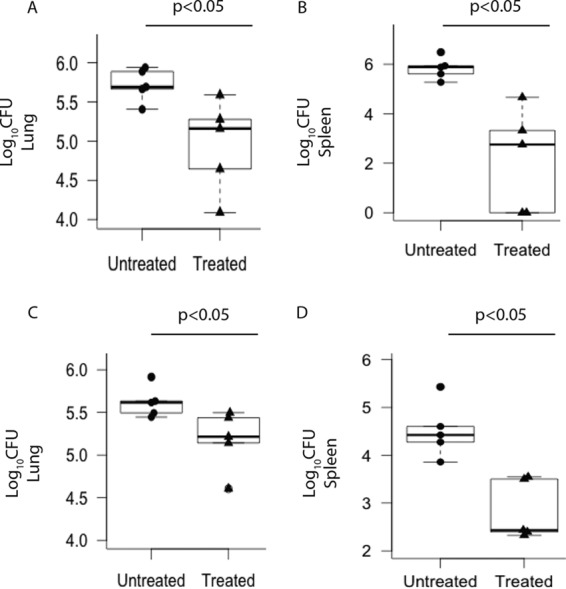
AZD0530 reduces infection in guinea pigs infected with M. tuberculosis. Outbred Dunkin-Hartley guinea pigs (n = 5) were infected with M. tuberculosis and were administered AZD0530 at a dose of 10 mg/kg. The bacillary load was determined by plating lung and spleen homogenates of treated and untreated animals. Bacterial CFU in whole lung and spleen tissues are shown here as box plots. (A and B) H37Rv CFU obtained at 8 weeks posttreatment in whole lung and whole spleen, respectively. (C and D) CFU from whole lung and whole spleen, respectively, in MYC431-infected guinea pigs at 8 weeks posttreatment. Each point represents data obtained from a single animal (P value < 0.05); P values were determined using the Mann-Whitney U rank sum test.